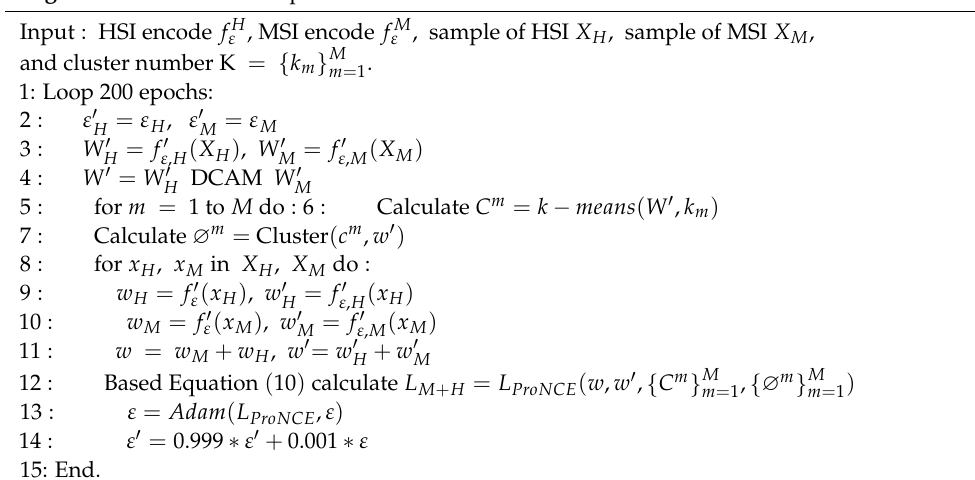
Algorithm 1 M-SSL model